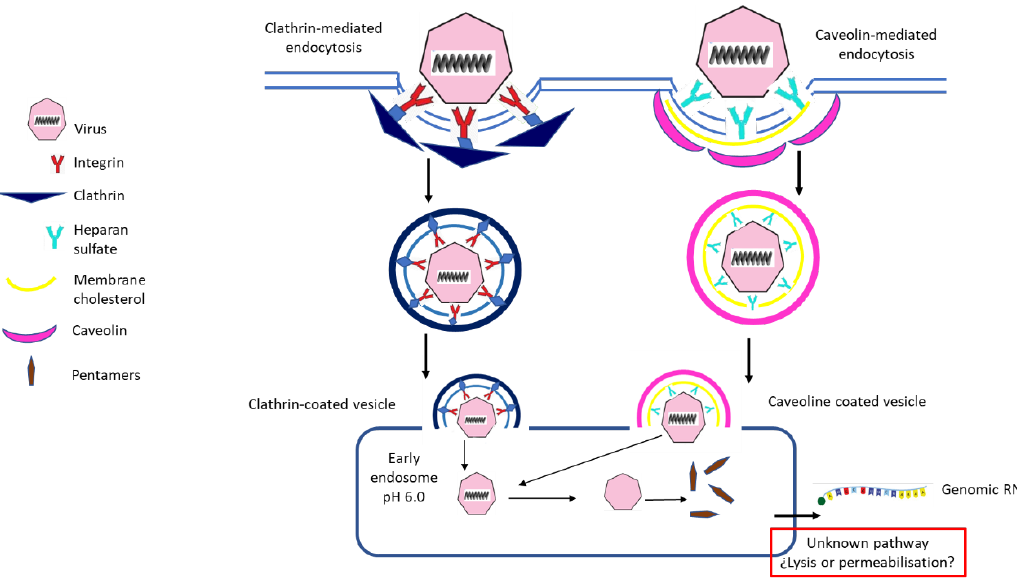
Figure 1. A scheme showing Foot-and-mouth disease virus (FMDV) entry to target cells. Adapted